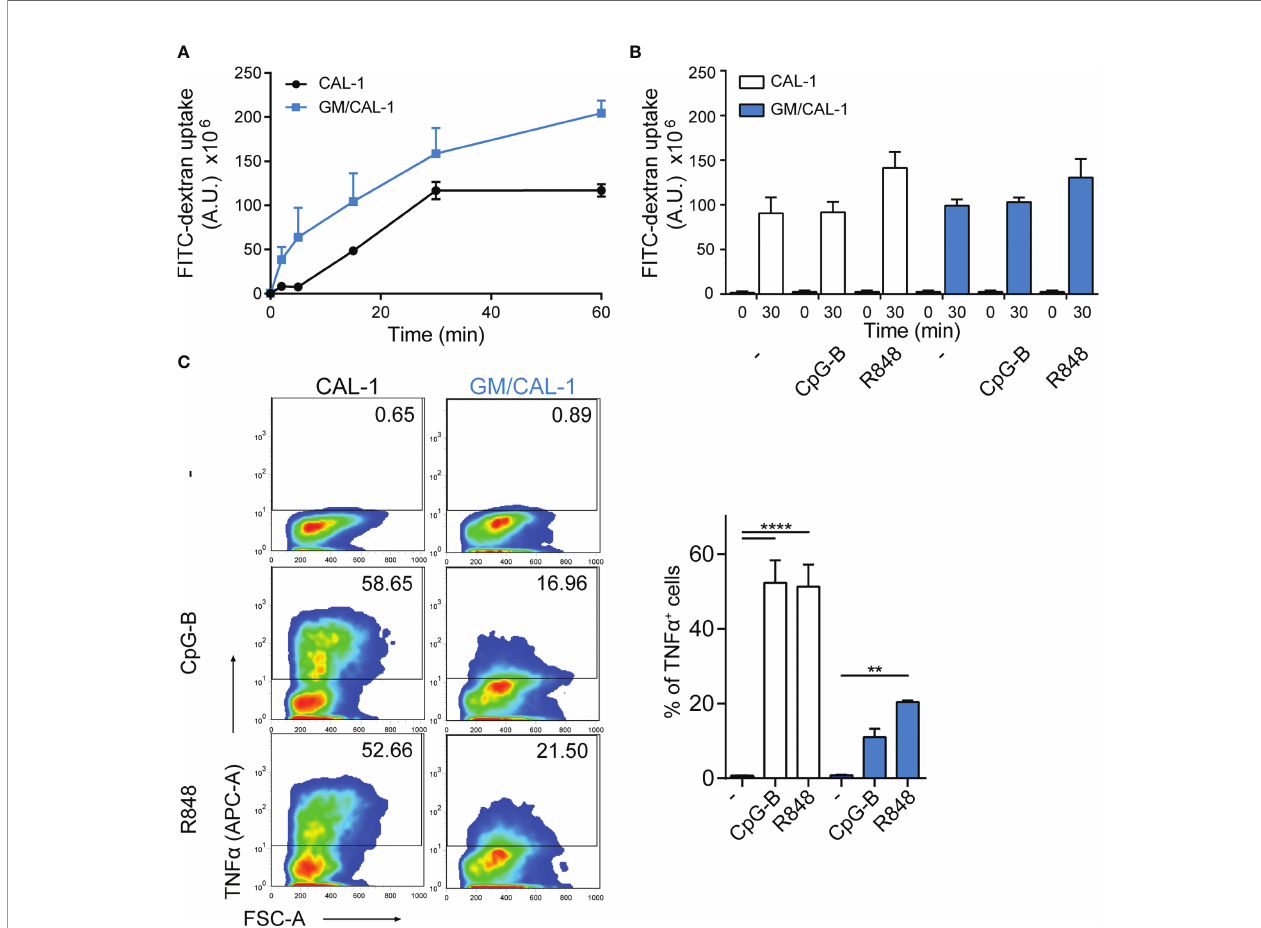
FIGURE 2 | FITC-dextran uptake and TNF a production by CAL-1 and GM/CAL-1 cells (A) Time-dependent FITC-dextran uptake by CAL-1 and GM/CAL-1 cells. CAL-1 cells were cultured in the absence (CAL-1; back line) or presence of GM-CSF (GM/CAL-1; blue line) for 3 days, pre-stimulated with R848 for 30min and subsequently incubated with 1mg/ml of FITC-dextran for indicated time periods at 37°C. Cells were extensively washed and FITC-dextran uptake was quanti fi ed by fl ow cytometry. The area under the curve [A.U.] was calculated by multiplying the mean fl uorescence intensity (MFI) values and the event count of live, FITC-positive cells. Mean values ± SEM of 3 independent experiments are shown. (B) FITC-dextran uptake by mature CAL-1 and GM/CAL-1 cells. CAL-1 (white bars) and GM/ CAL-1 (blue bars) were left untreated ( – ) or matured with either CpG-B or R848 for 24h. FITC-dextran uptake at t=0 or t=30min of incubation with 1mg/ml of FITC- dextran was determined and quanti fi ed by fl ow cytometry as in (A) . Mean values ± SEM of 3 independent experiments are shown. (C) TNF a production by CAL-1 and GM/CAL-1 cells. CAL-1 or GM/CAL-1 cells were stimulated or not with CpG-B or R848 for 6h. For the last 4h of incubation 10 m g/ml Brefeldin A was added to prevent cytokine secretion. Cells were fi xed, permeabilized, and the percentage of cells with intracellularly accumulated TNF a was determined by ICS and fl ow cytometry. One representative pseudocolor dot plot (left panels) and quanti fi cation of three (bar graphs on the right panel; CAL-1: white bars, GM/CAL-1: blue bars) independent experiments are shown as mean values ±